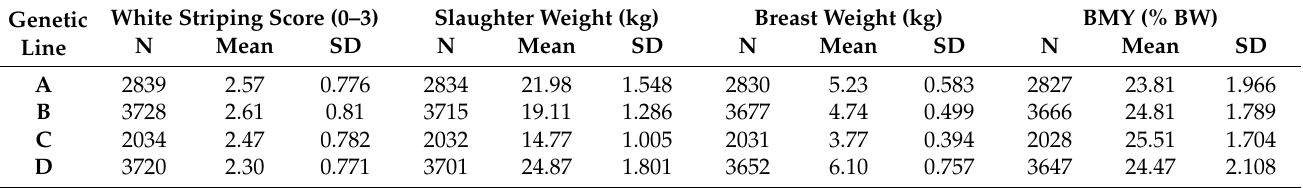
Table 3. Descriptive statistics (count, mean, and standard deviation) for white striping score, slaughter weight, breast weight, and breast meat yield (BMY) for the four genetic lines of turkeys